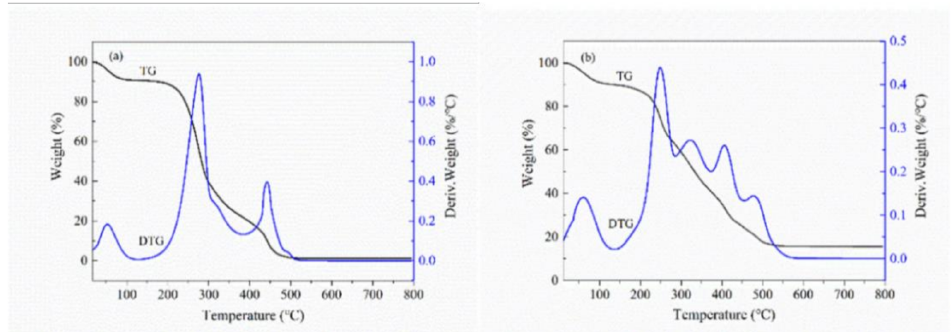
Figure 8. ( a ) DTG curves of GA-BX/AD. ( b ) DTG curves of GA-BX/AD-g-IA.